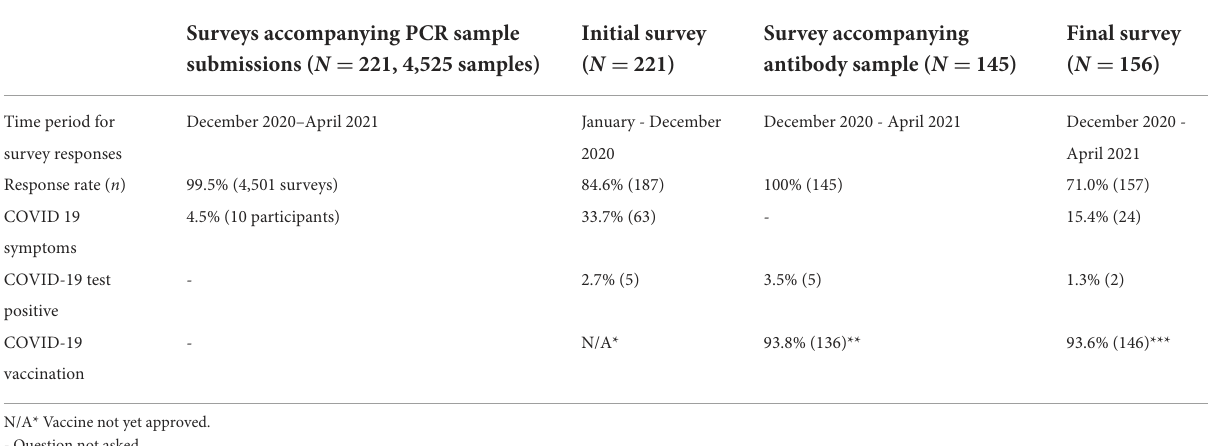
TABLE 3 Attributes and responses of surveys distributed during the study period.